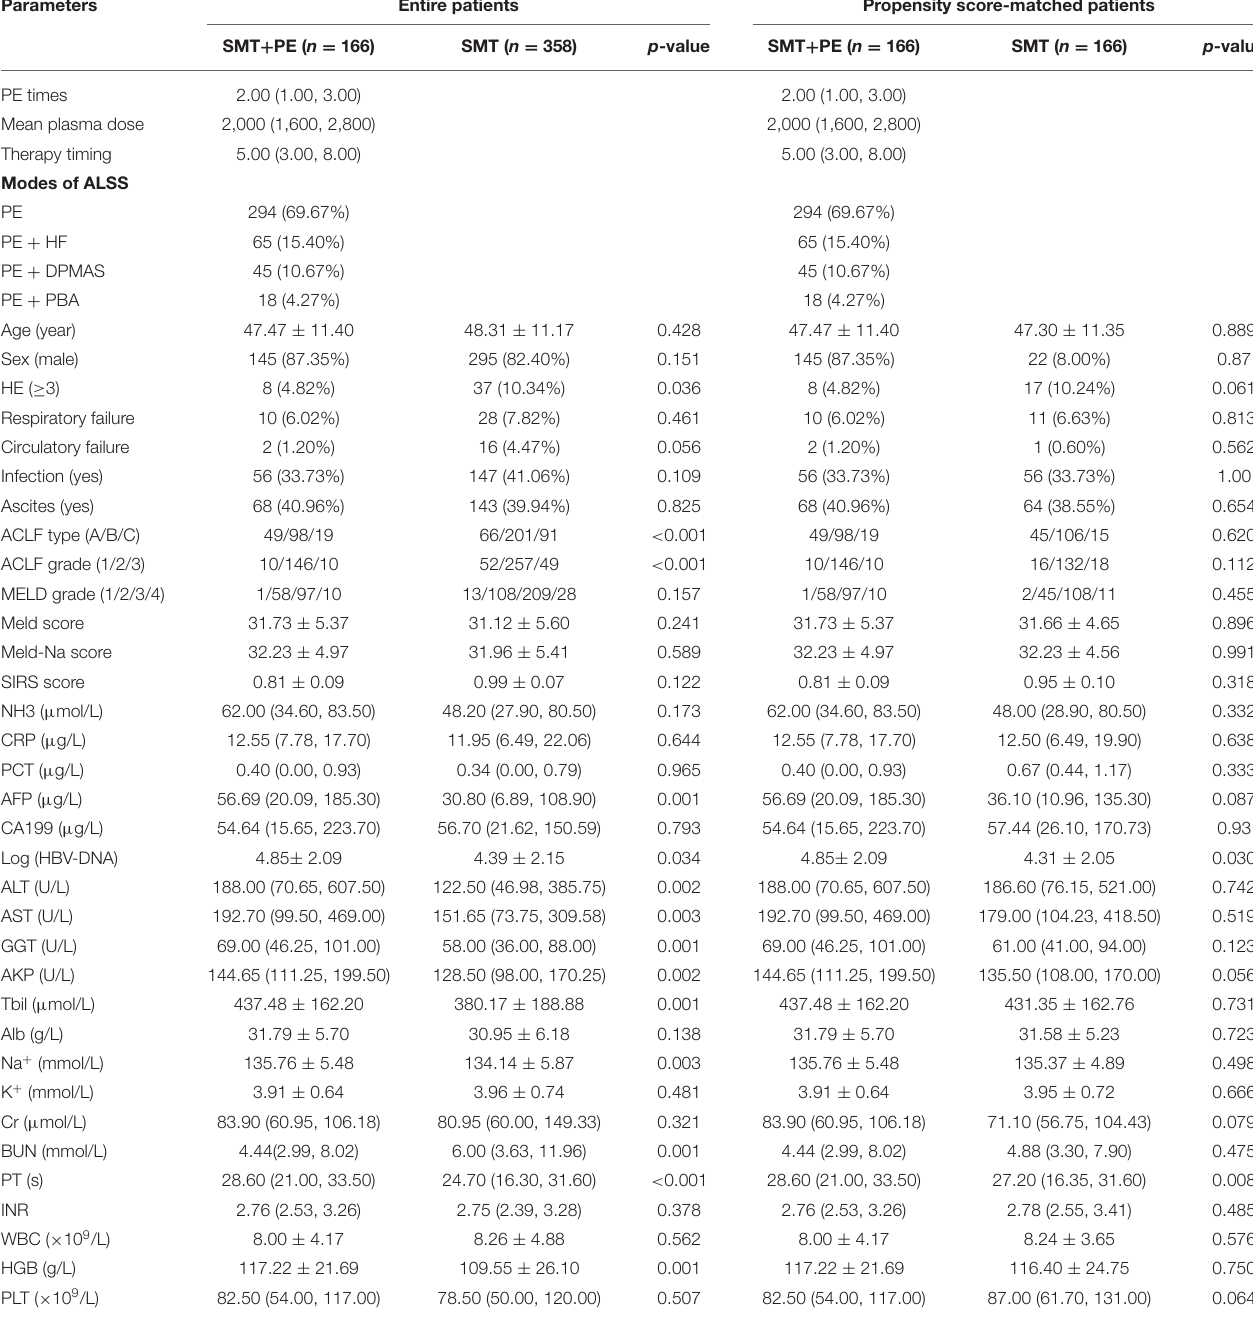
TABLE 1 | Baseline characteristics of HBV-ACLF patients who received SMT alone or SMT + PE. Parameters Entire patients Propensity score-matched